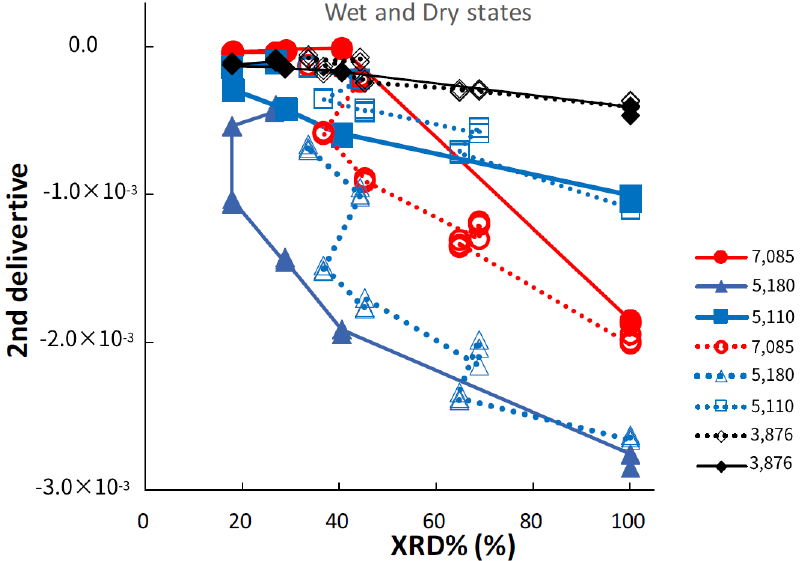
Figure 8. Relationships between NIRS peak intensities at specific bands in second-derivative spectra of the ground S-CP products during wet or dry grinding and their XRD%. The solid and dotted lines indicate the changes in the intensity owing to wet and dry grinding, respectively.